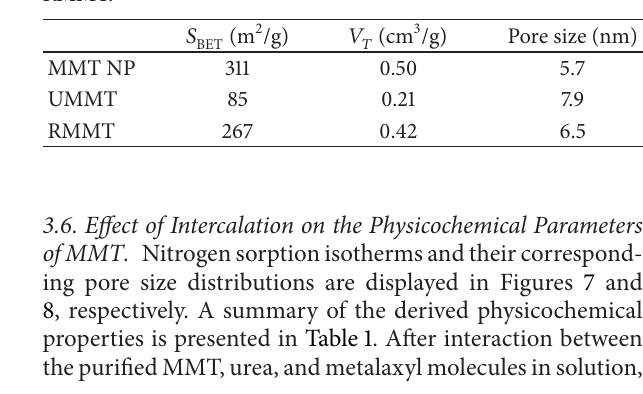
Table 1: Physicochemical properties of MMT NP, UMMT and